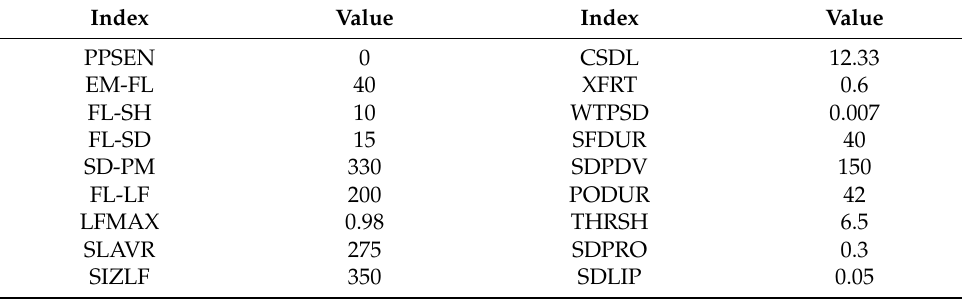
Table 4. Calibrated genotype coefficients of bell pepper in